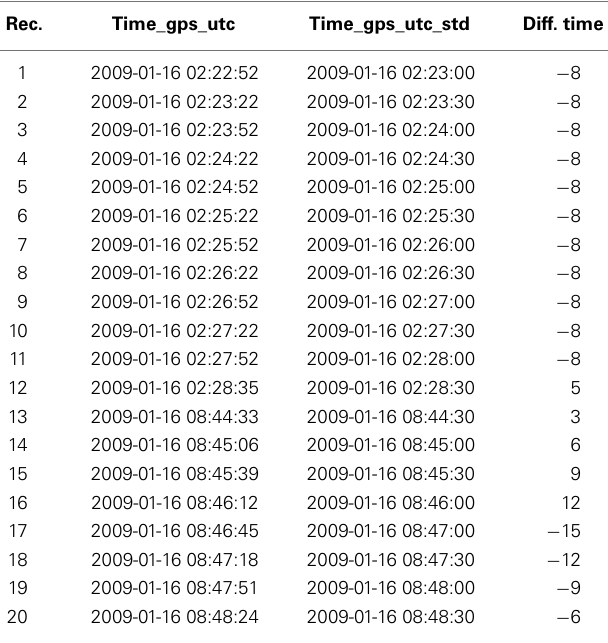
Table 1 | Illustration of original and rounded timestamps from one